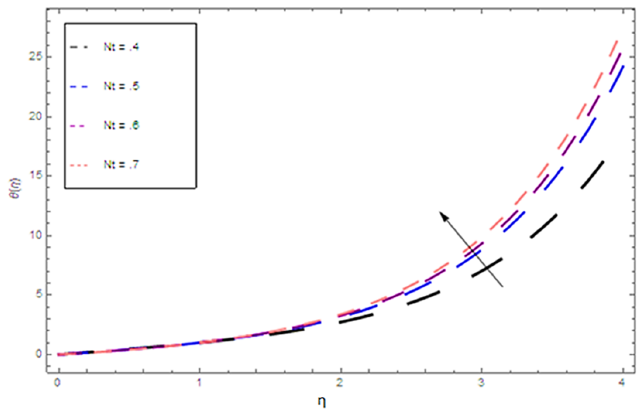
Figure 11. The e ff ect of Nb on θ ( η ) when M = 0.3, Ω = 1, S = 0.5,Pr = 2, Sc = 0.7, Nt = 0.5. Figure 11. The effect of Nb on Figure 11. The effect of Nb on